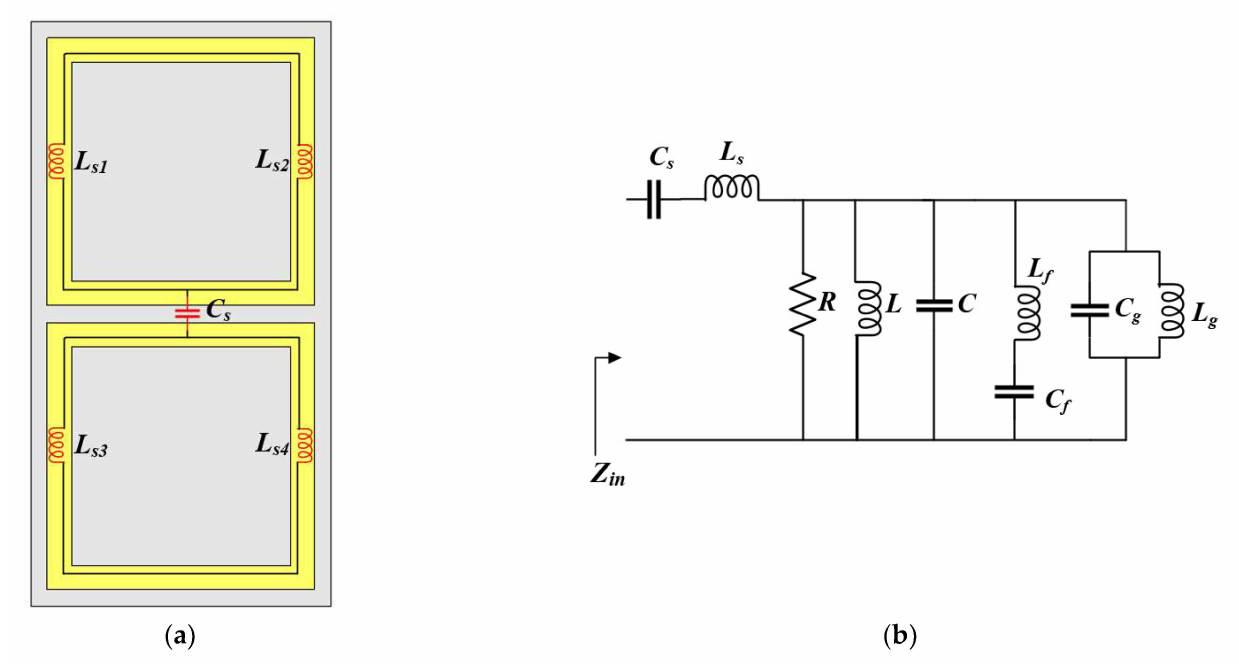
Figure 9. Illustration of ( a ) FSS unit cell layer with inductive and capacitive components and ( b ) equivalent circuit model of proposed antenna structure with both cross-ground and FSS unit cells.